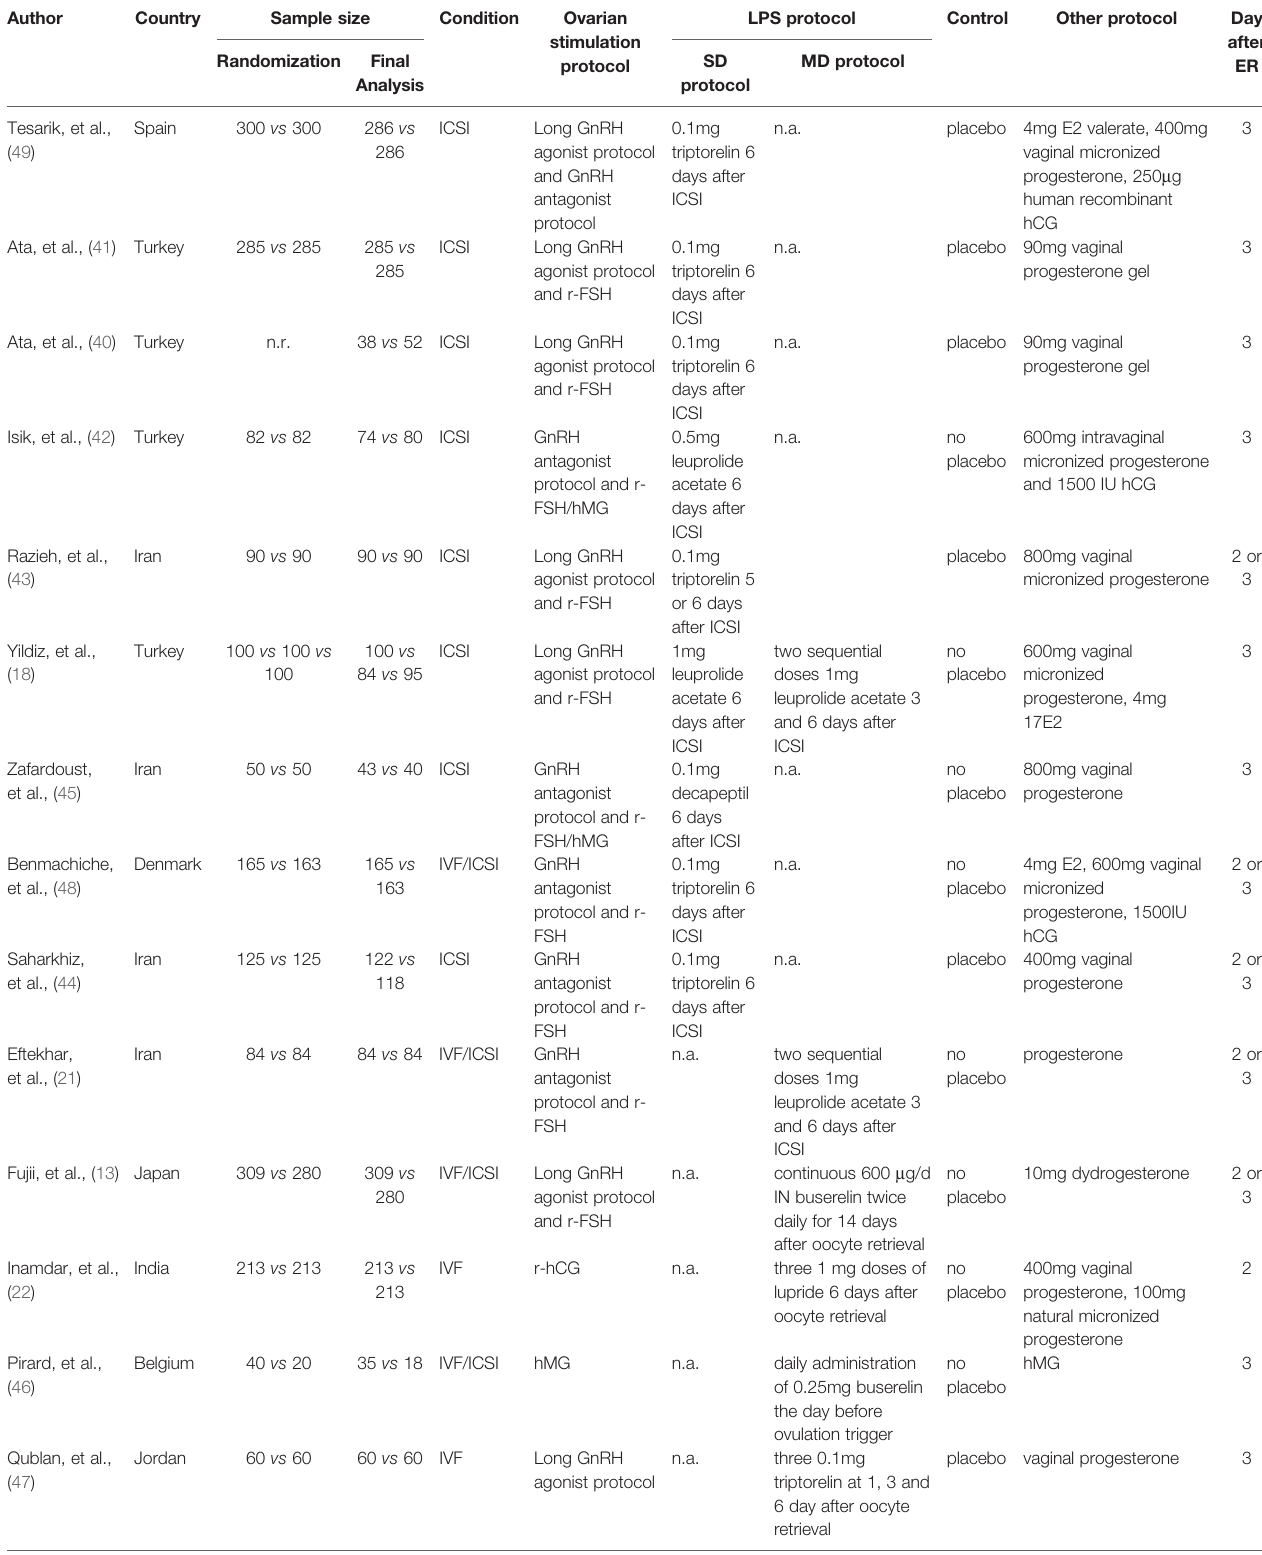
TABLE 1 | Characteristics of the included studies